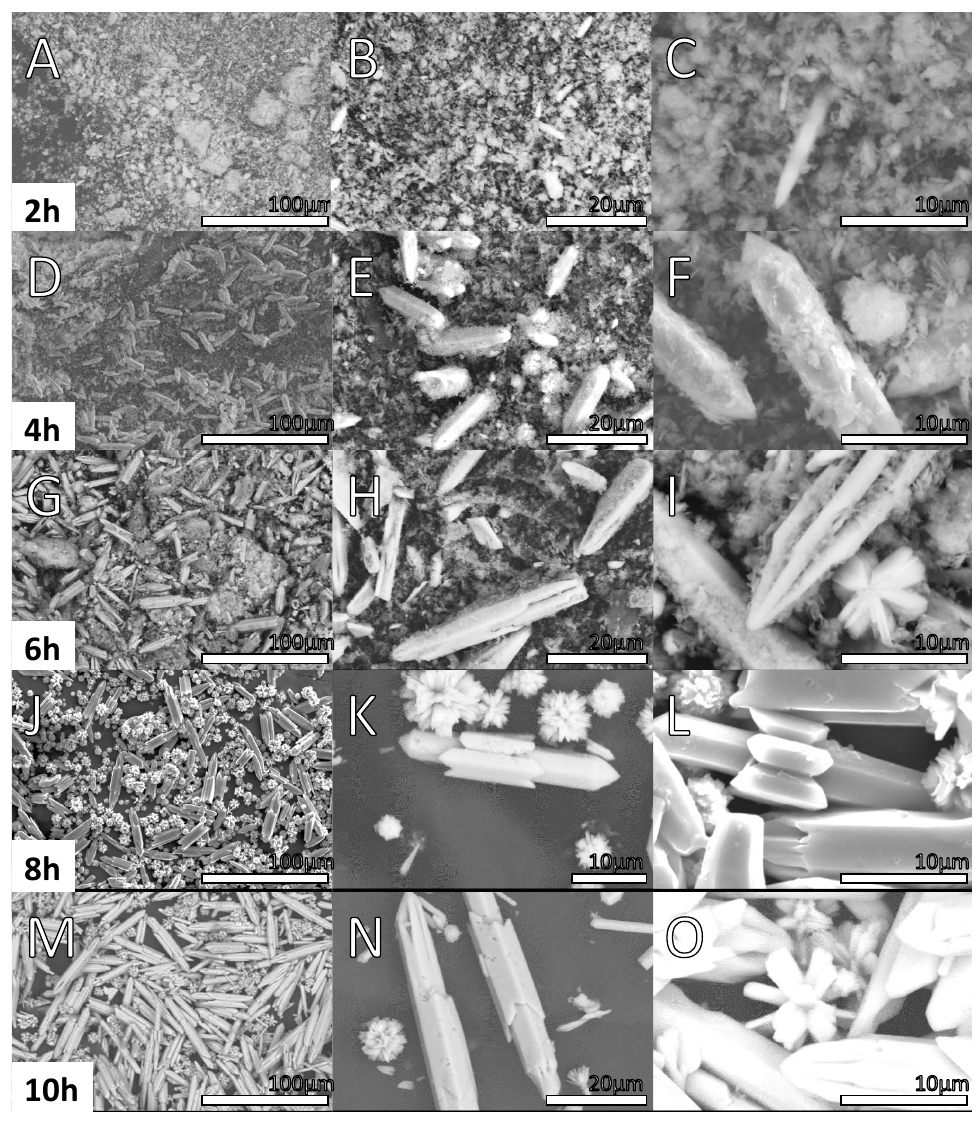
Figure 6 SEM micrographs of Y(OH) 3 Samples obtained at 2, 4, 6, 8 and 10 h. Full-size DOI: